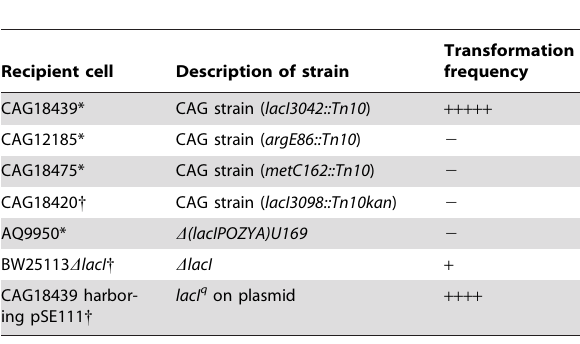
Table 7. Effects of Tn10 and lacI mutations on cell-to-cell transformation.